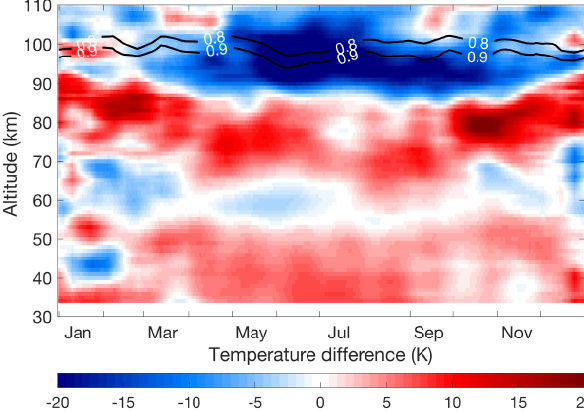
Figure 5. A typical night’s systematic and random uncertainties for the OEM temperature